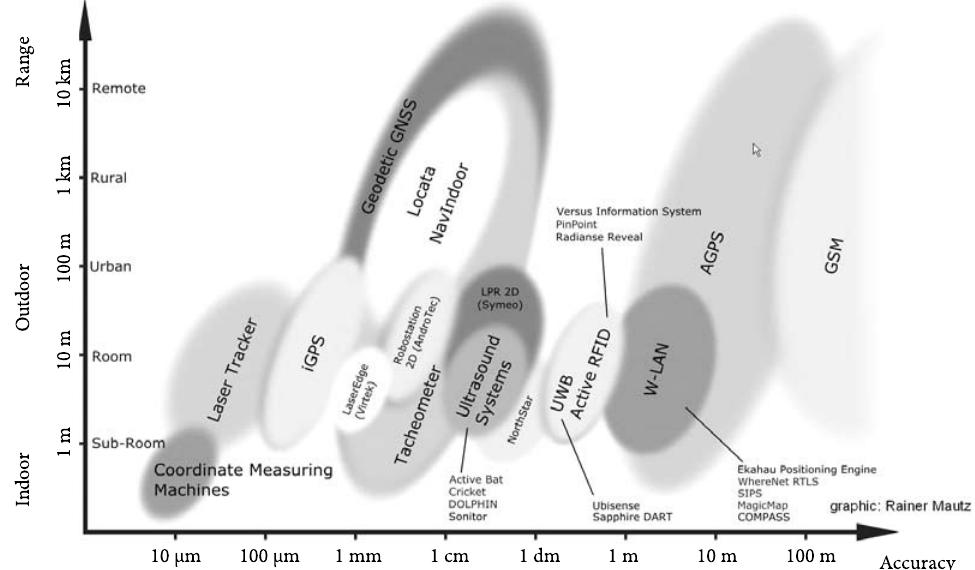
fig. 1. Current positioning systems according to their accuracy and coverage area